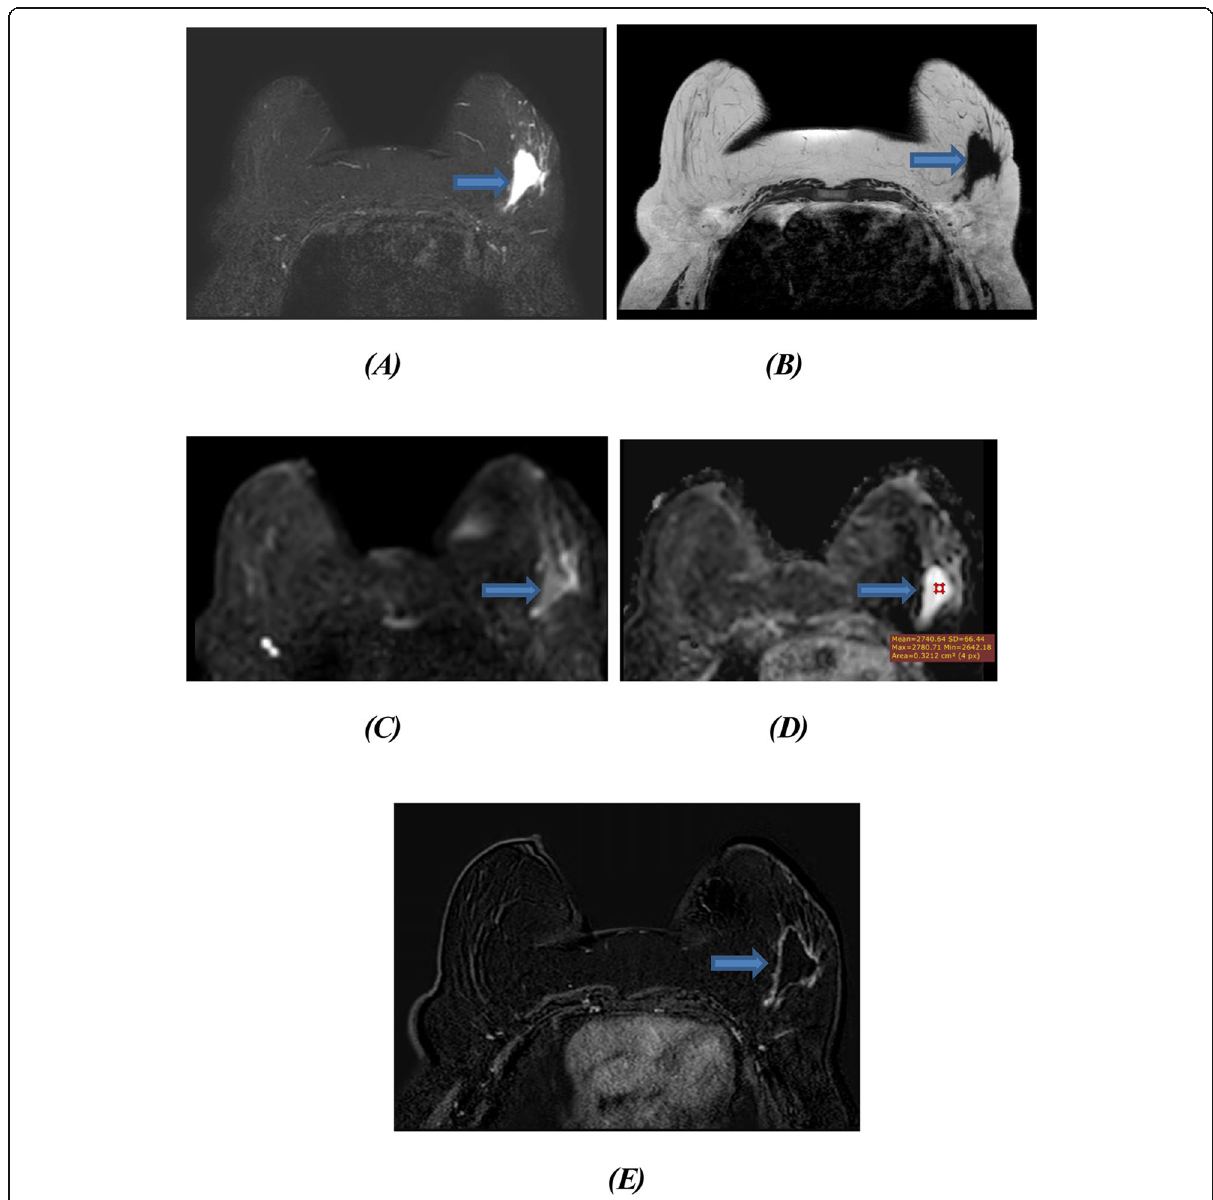
Fig. 3 Female patient aged 51 years with history of left breast cancer underwent conservative breast surgery and then presented by palpable left breast mass. a Axial STIR image showed lesion of high signal intensity. b Axial T1WI, the lesion appeared of low signal intensity. c , d DWI and ADC map, the lesion appeared free on diffusion with a mean ADC value = 2.5 × 10 – 3 mm 2 /s. e Subtraction MR Image, the lesion, showed thin smooth marginal enhancement. FNAC show post-operative seroma with no malignant cells